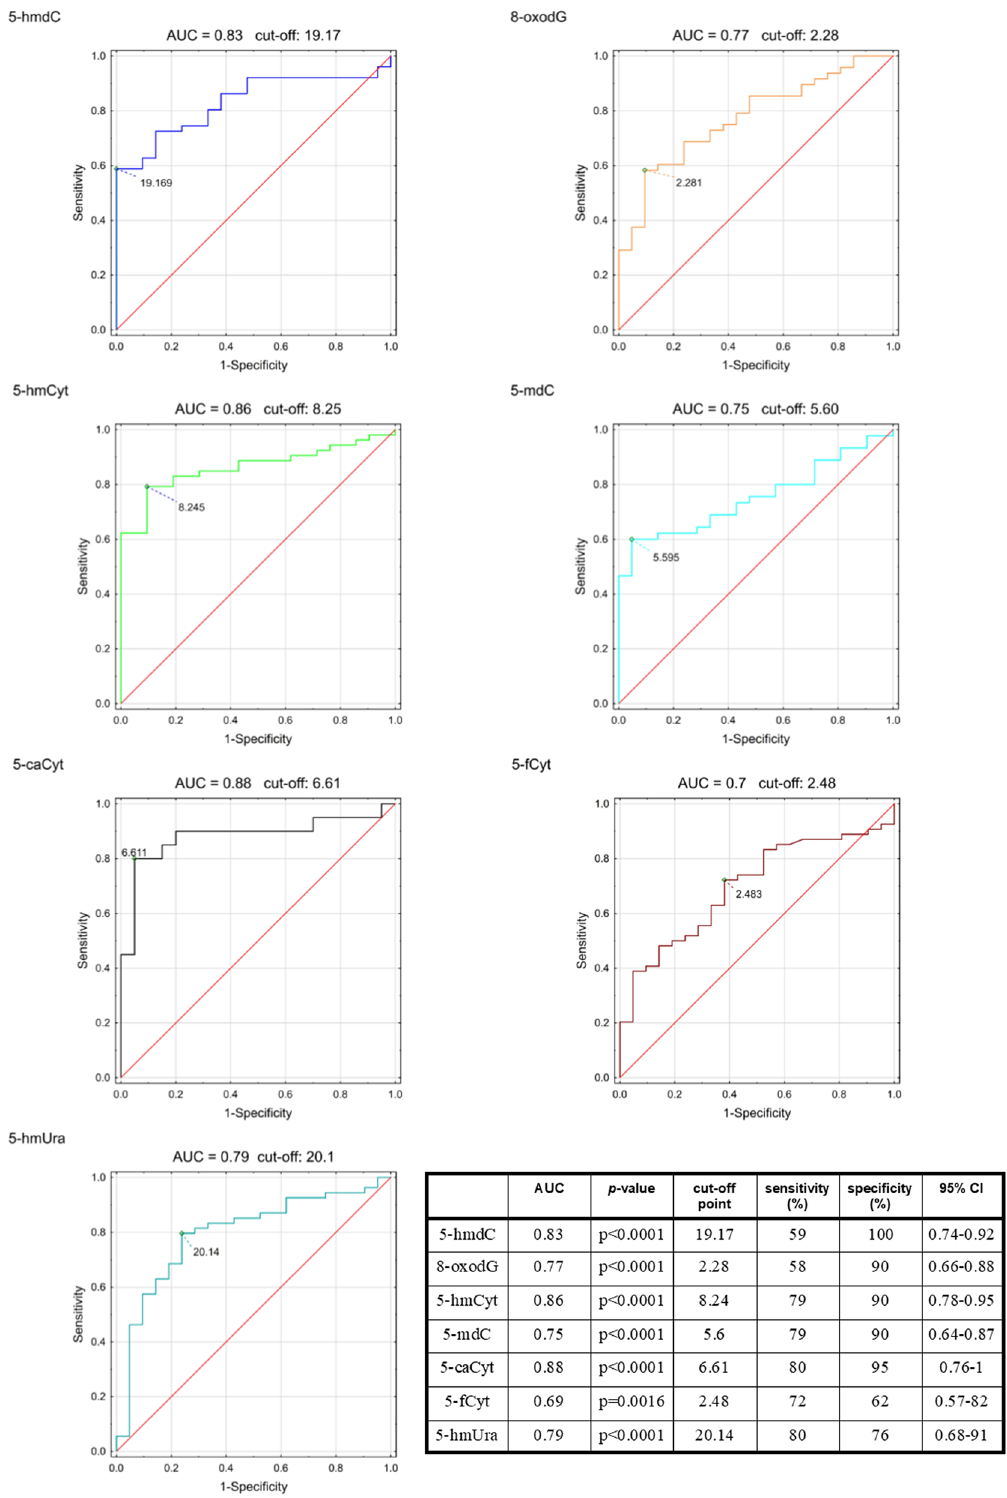
Figure 2. Receiver operating characteristic (ROC) curves for epigenetically modified DNA markers in urine (*p<0.05). AUC area under the